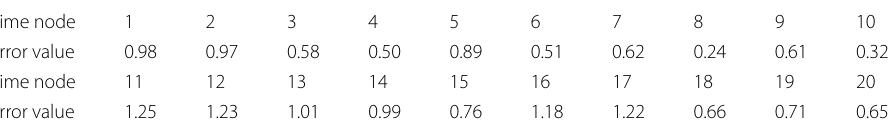
Table 5 Mobile node localization test